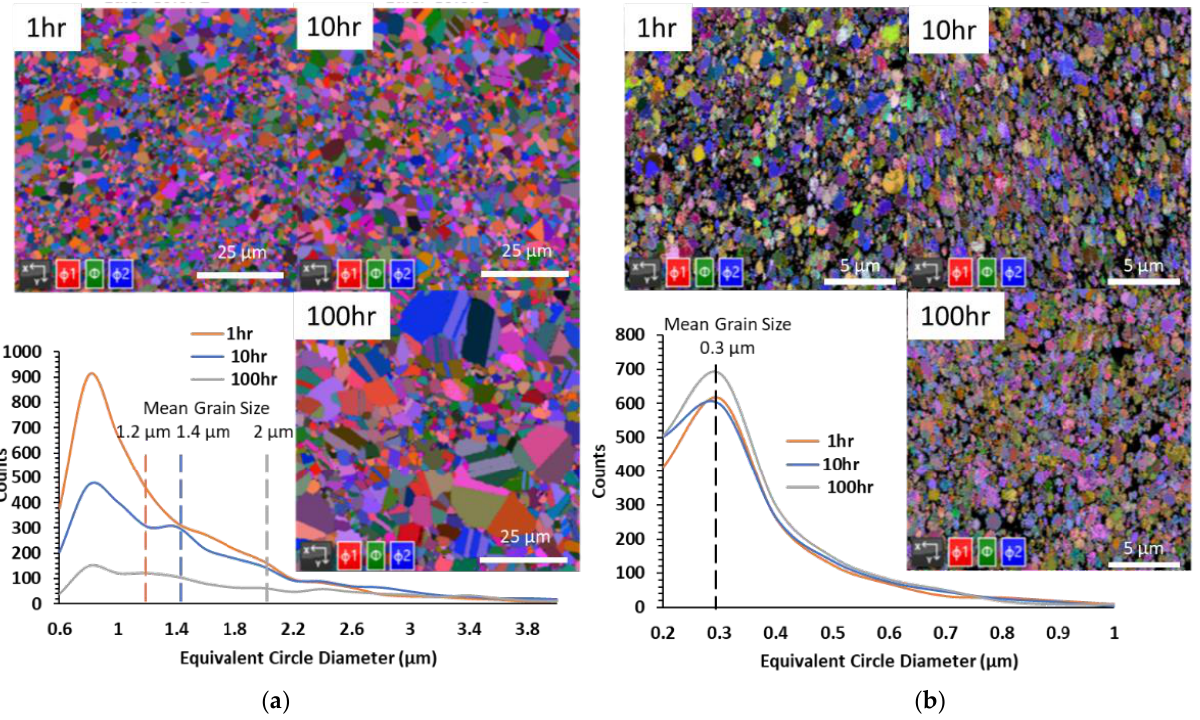
Figure 13. Grain size distribution and orientation for the single layer TBC ( a ) bond coat, ( b ) YSZ